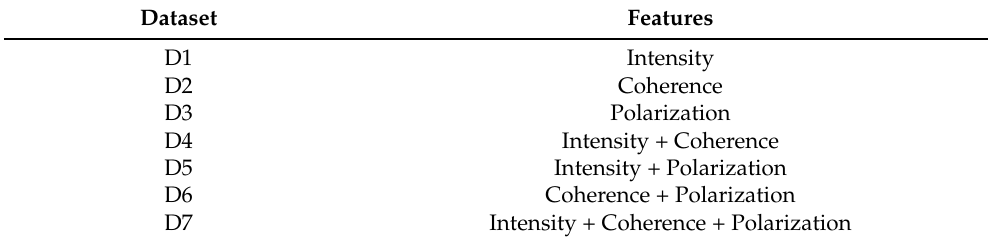
Table 3. The seven datasets constructed in this